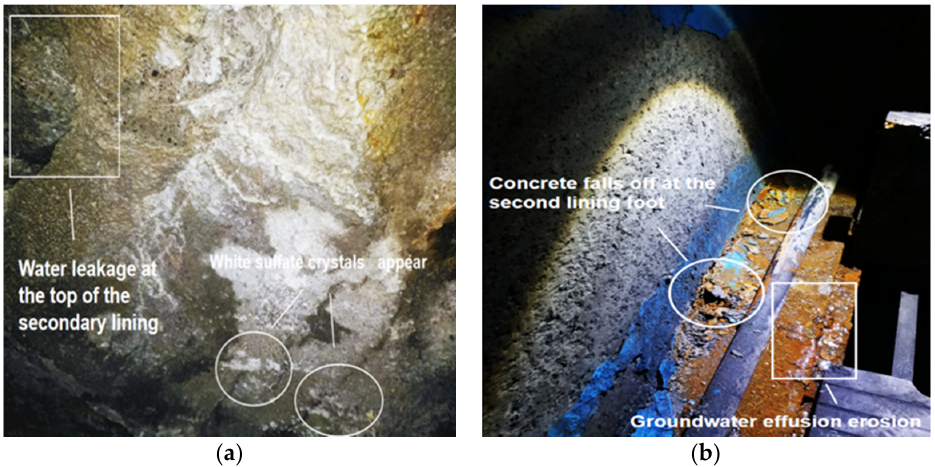
Figure 1. Corrosion of tunnel: ( a ) sulfate crystals precipitated from tunnel concrete; ( b ) collapse and spalling of concrete with secondary lining feet.